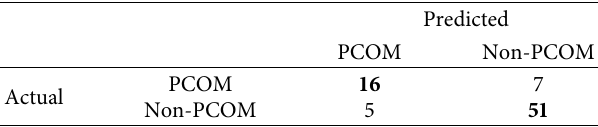
Table 3: Confusion matrix for inception model.